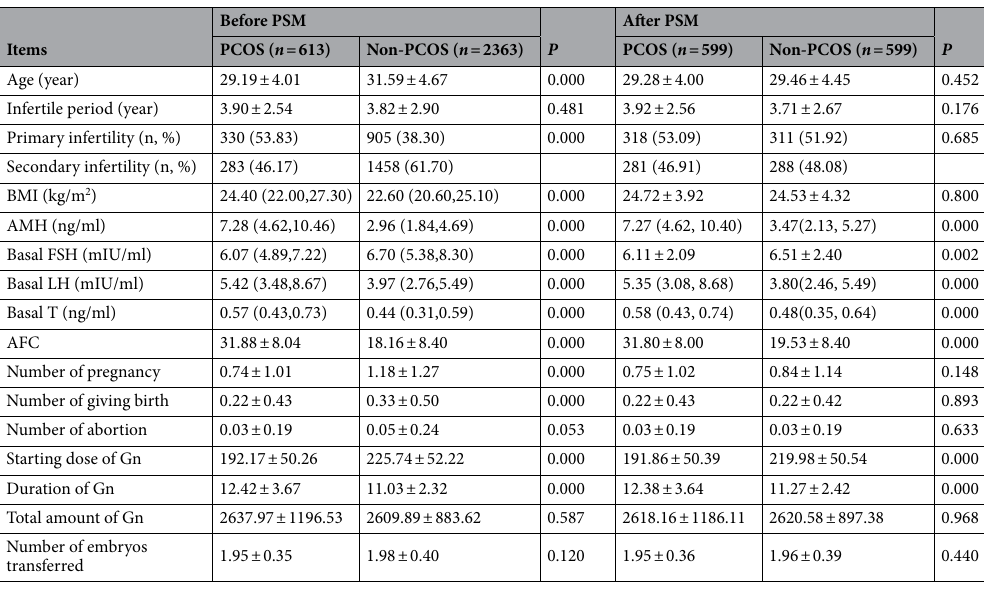
Table 1. Comparisons of baseline data between PCOS and non-PCOS clinical pregnancy cycles. PCOS, polycystic ovary syndrome; PSM, propensity score matching; BMI, body mass index, AMH, Anti-Mullerian hormone; FSH, follicle-stimulating hormone; LH, luteinizing hormone; T, testosterone; Gn, gonadotrophin.